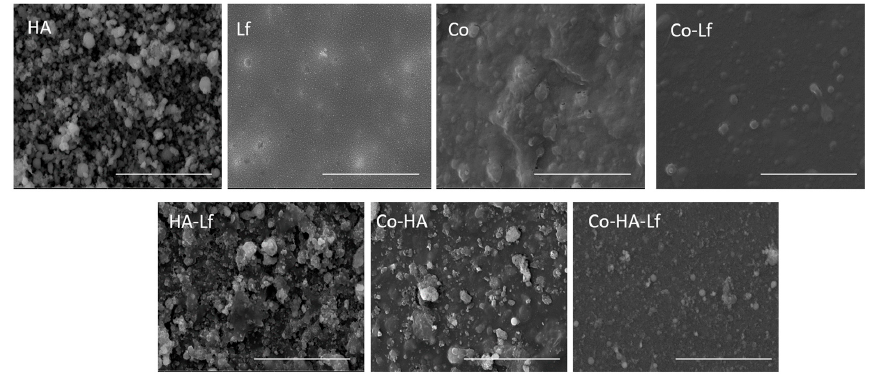
Figure 1. SEM images of the top morphology of the coatings obtained by Matrix Assisted Pulsed Laser Evaporation (MAPLE). Scale bar: 10 µ m. HA: hydroxyapatite; Lf: